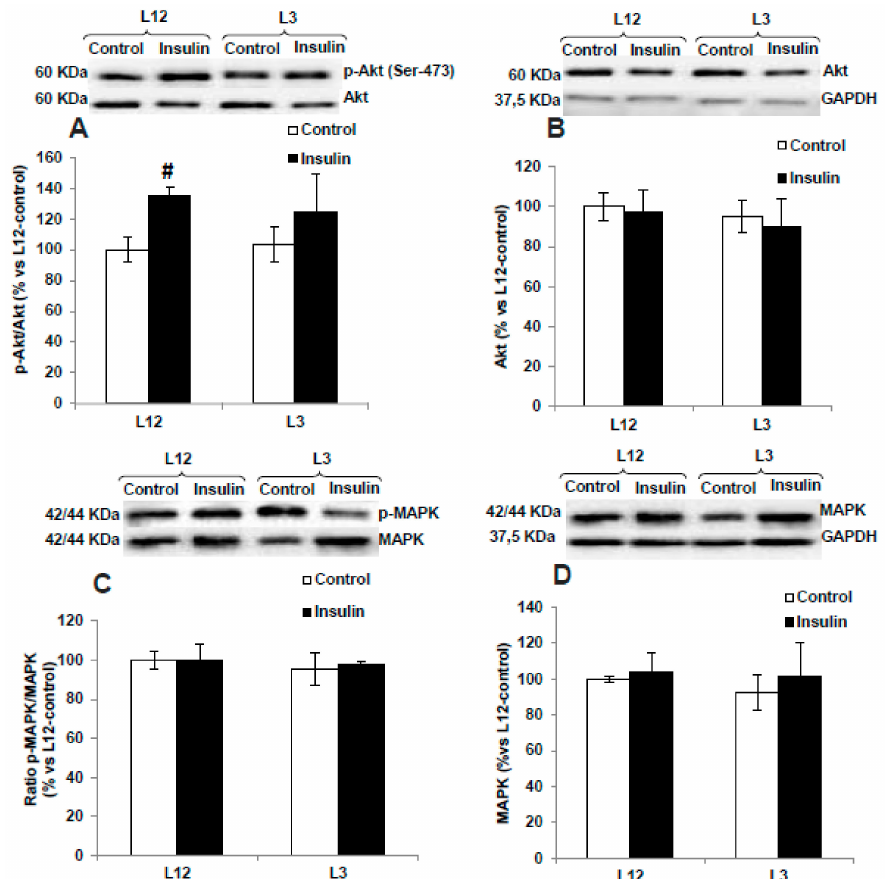
Figure 7. Protein levels of ( A ) ratio of phosphorylated to total Akt (p-Akt / Akt), ( B ) total Akt (Akt), ( C ) ratio of phosphorylated to total MAPK (p-MAPK / MAPK), and ( D ) total MAPK (MAPK) in aortas from rats raised in L12 or L3 litters, incubated with vehicle (control) or with insulin (10 − 7 M) for 30 min. Note: # p < 0.05; di ff erence between hearts incubated with insulin and control. Values are represented as mean ± SEM ( n = 6–9 rats / experimental group) and expressed as % vs. L12. Data were analyzed by two-way ANOVA followed by Bonferroni post-hoc